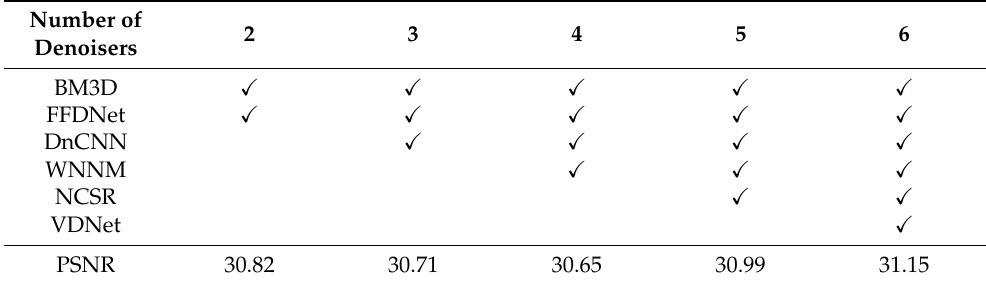
Table 2. Average performance of different numbers of combinations on 10 commonly used images with noise level